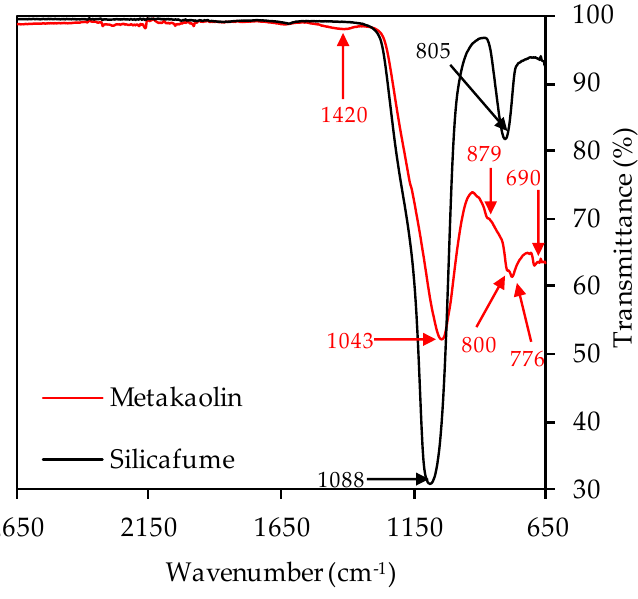
Figure 5. FTIR spectra of metakaolin and silica fume.